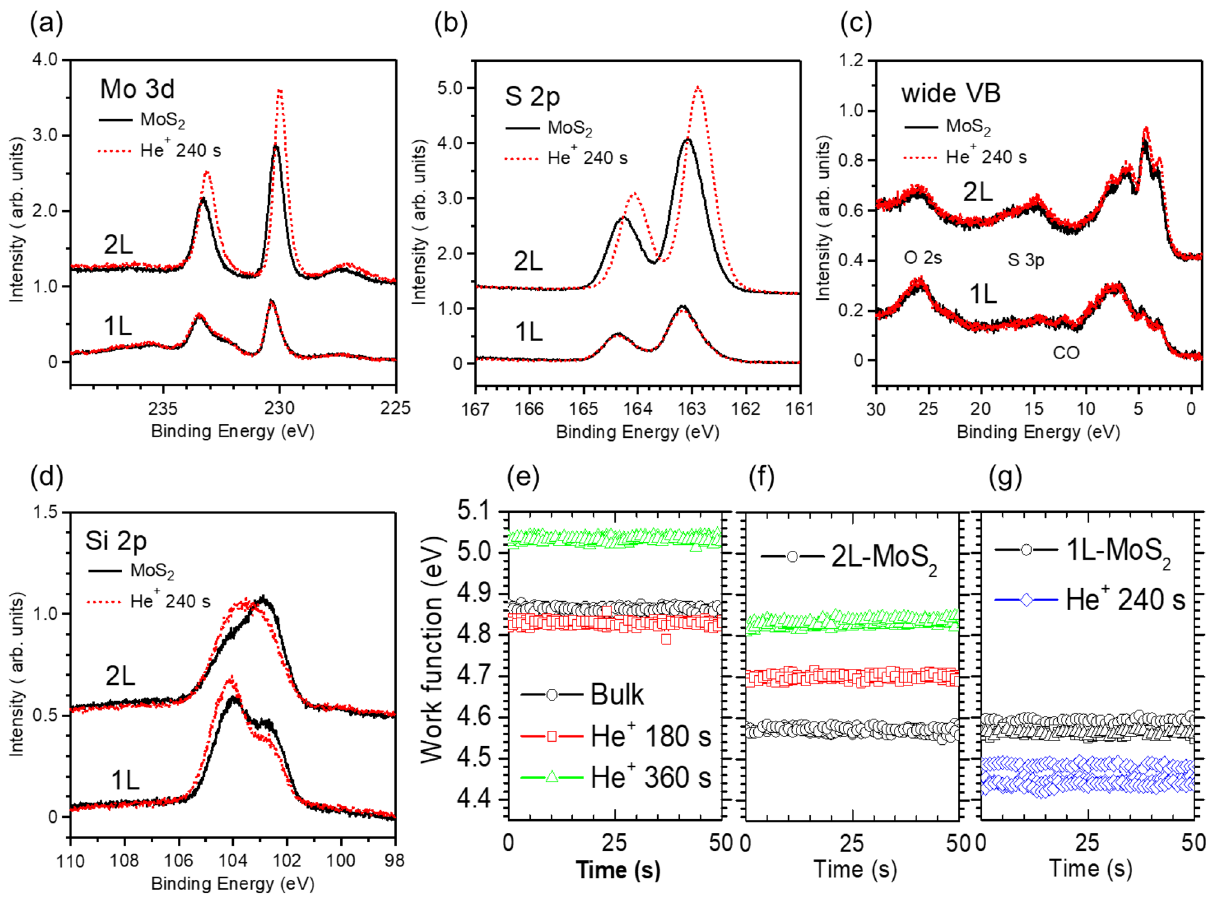
Figure 4. ( a – d ) Comparison of photoemission spectra between the CVD-grown 1L- and 2L-MoS 2 samples before and after low-energy (100 eV) He + ion irradiation. The photoemission data were taken at the photon energy of hν = 360 eV. ( e – g ) The work functions were measured at three random positions for each sample using an ambient Kelvin probe